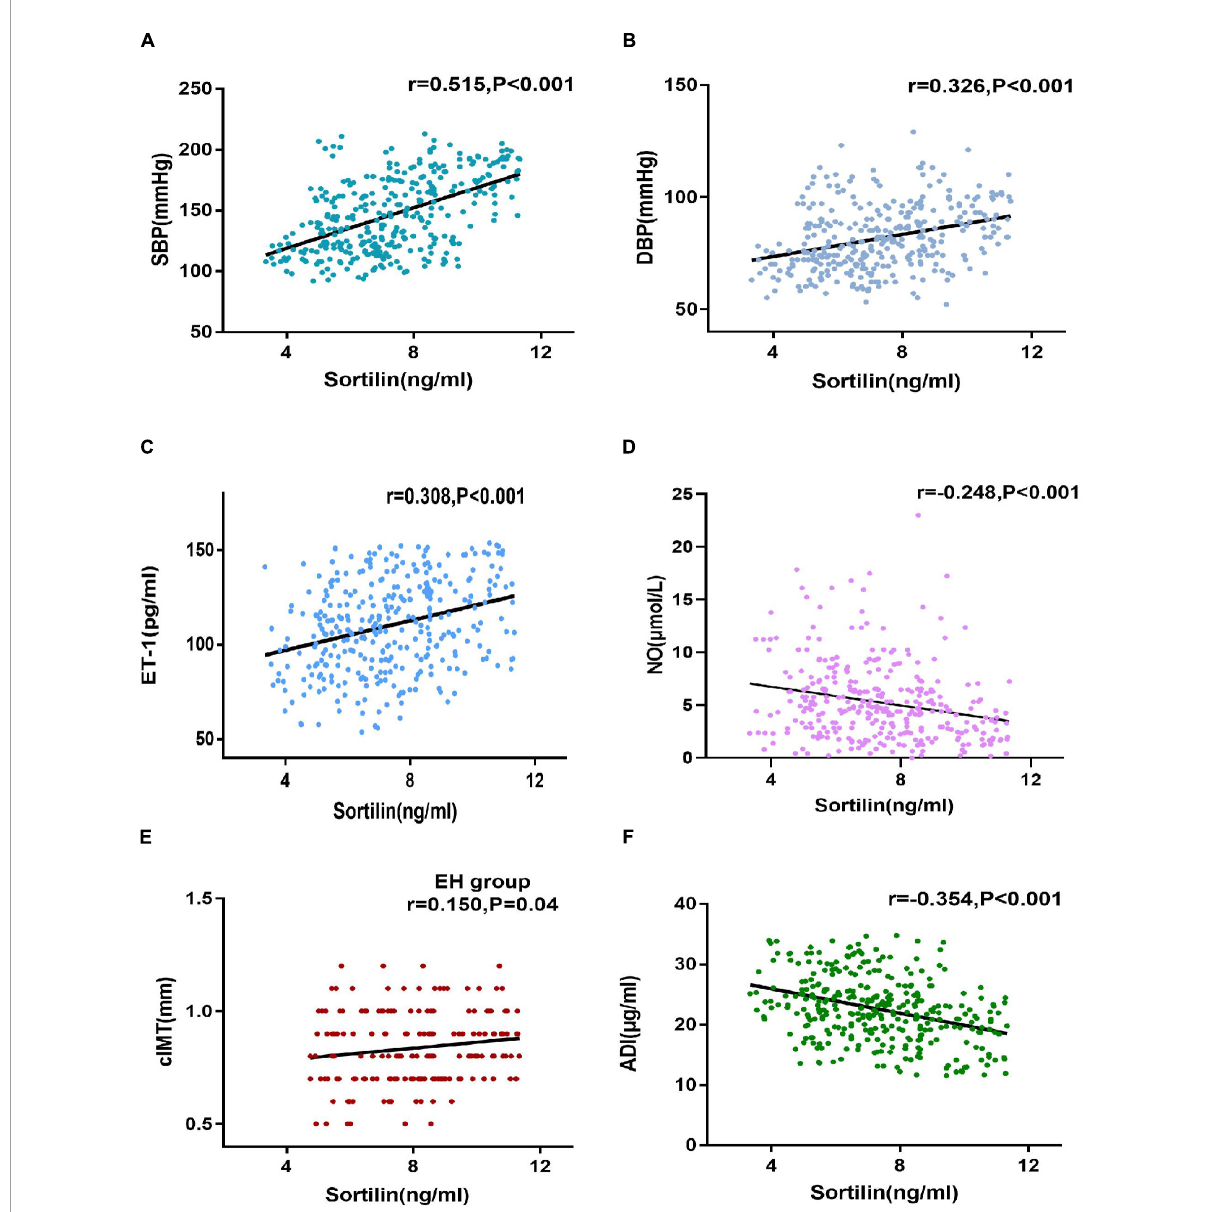
FIGURE2 Correlations of sortilin levels and parameters. (A–F) Correlations of sortilin levels and SBP (A) , DBP (B) , ET-1 (C) , NO (D) , and ADI (F) in the general population. Correlations of sortilin levels and cIMT (E) in the EH